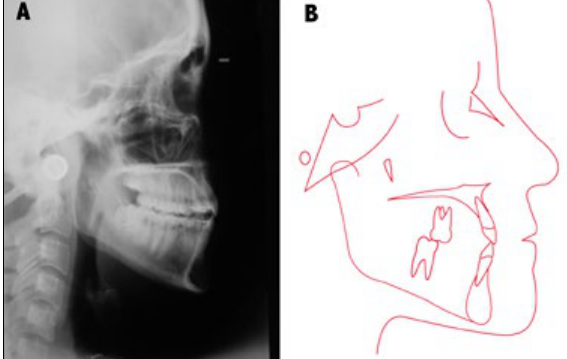
Figure 12. Post-treatment lateral cephalogram (A) and cephalometric tracing (B).